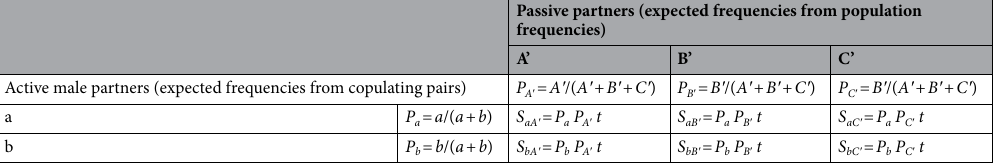
Table 1. Calculation of expected frequencies in the mating model used in the study. The process is illustrated with two types of active three types of passive partners; the same logic applies to a different number of partner types. A ′ , B ′ , C ′ —the number of passive partners of the types studied, counted from the population frequencies. P A ′ , P B ′ , P C ′ —probability to be a passive partner in copulation, estimated from the numbers in the population. a, b—numbers of active male partners of the types studied, counted from copulating pairs. P a P b —probability of copulation for a given type of active male partner, estimated form the frequency of this type of partner in copulating pairs. t = aA ′ + aB ′ + aC ′ + bA ′ + bB ′ + bC ′ —tot al observed number of copulating pairs. S aA ′ , S bA ′ , S aB ′ , S bB ′ , S aC ′ , S bC ′ —the expected number of pairs in each combination of partners.